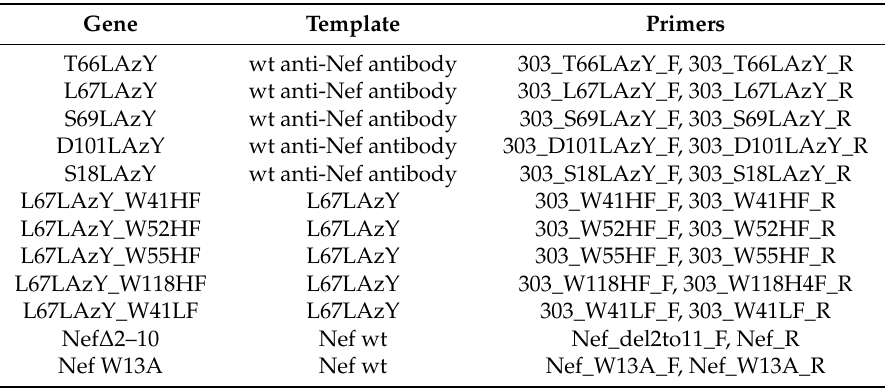
Table 2. Template and primers used for the construction of the